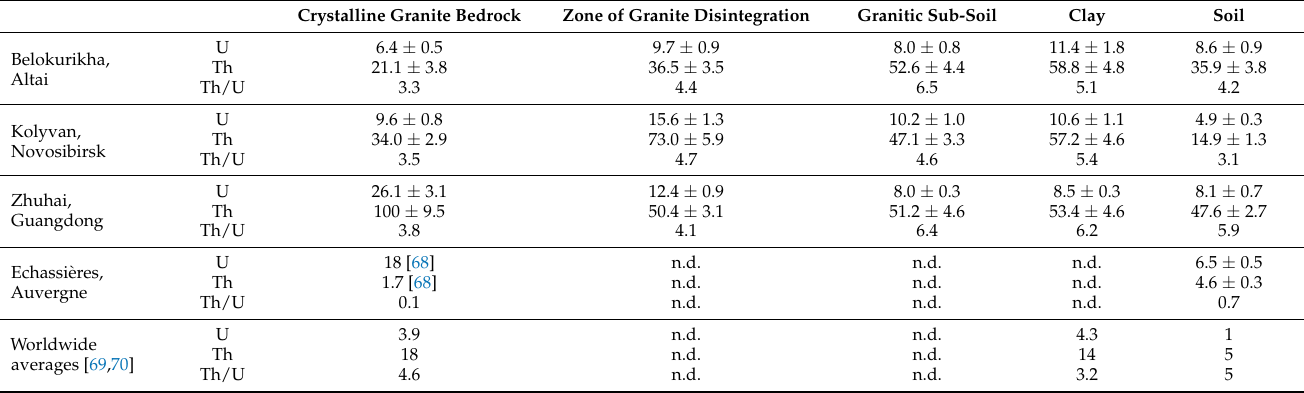
Table 1. Concentration of natural radioactive elements (g/t) and thorium–uranium ratio in